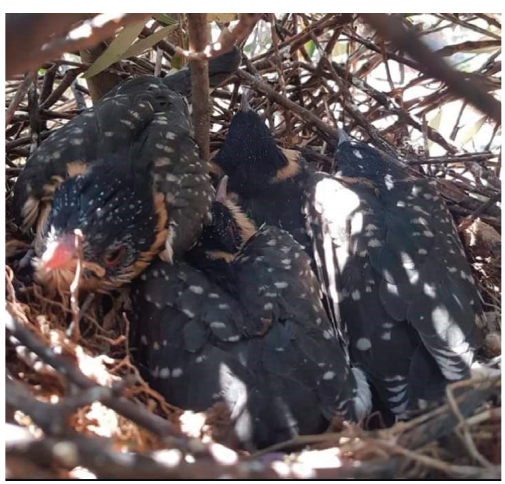
Figure 7: Magpie nest totally colonized by the great spotted